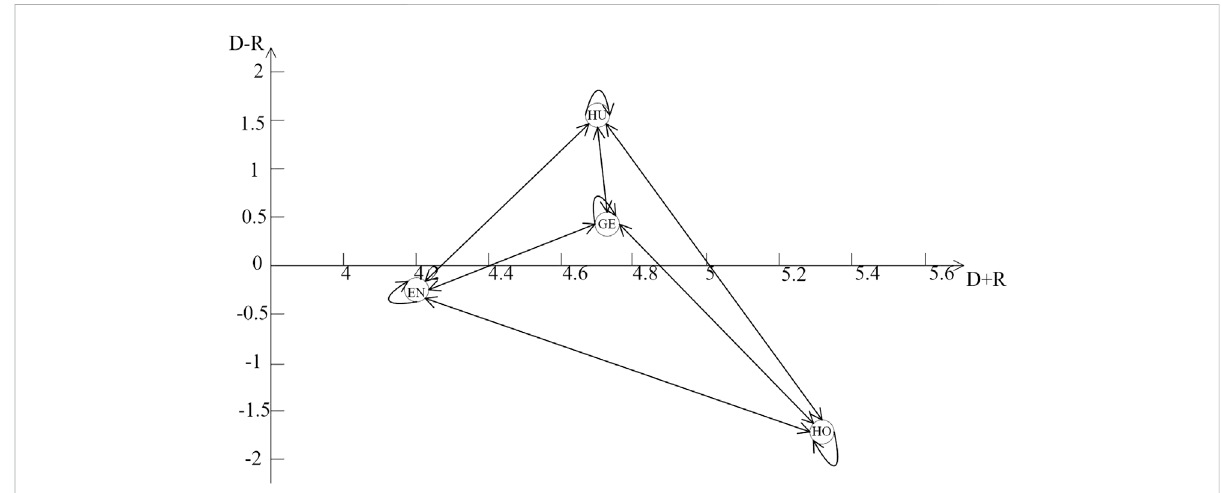
FIGURE 4 The causal relationship between the indicators of green users ’ emotional tendencies at the element level.